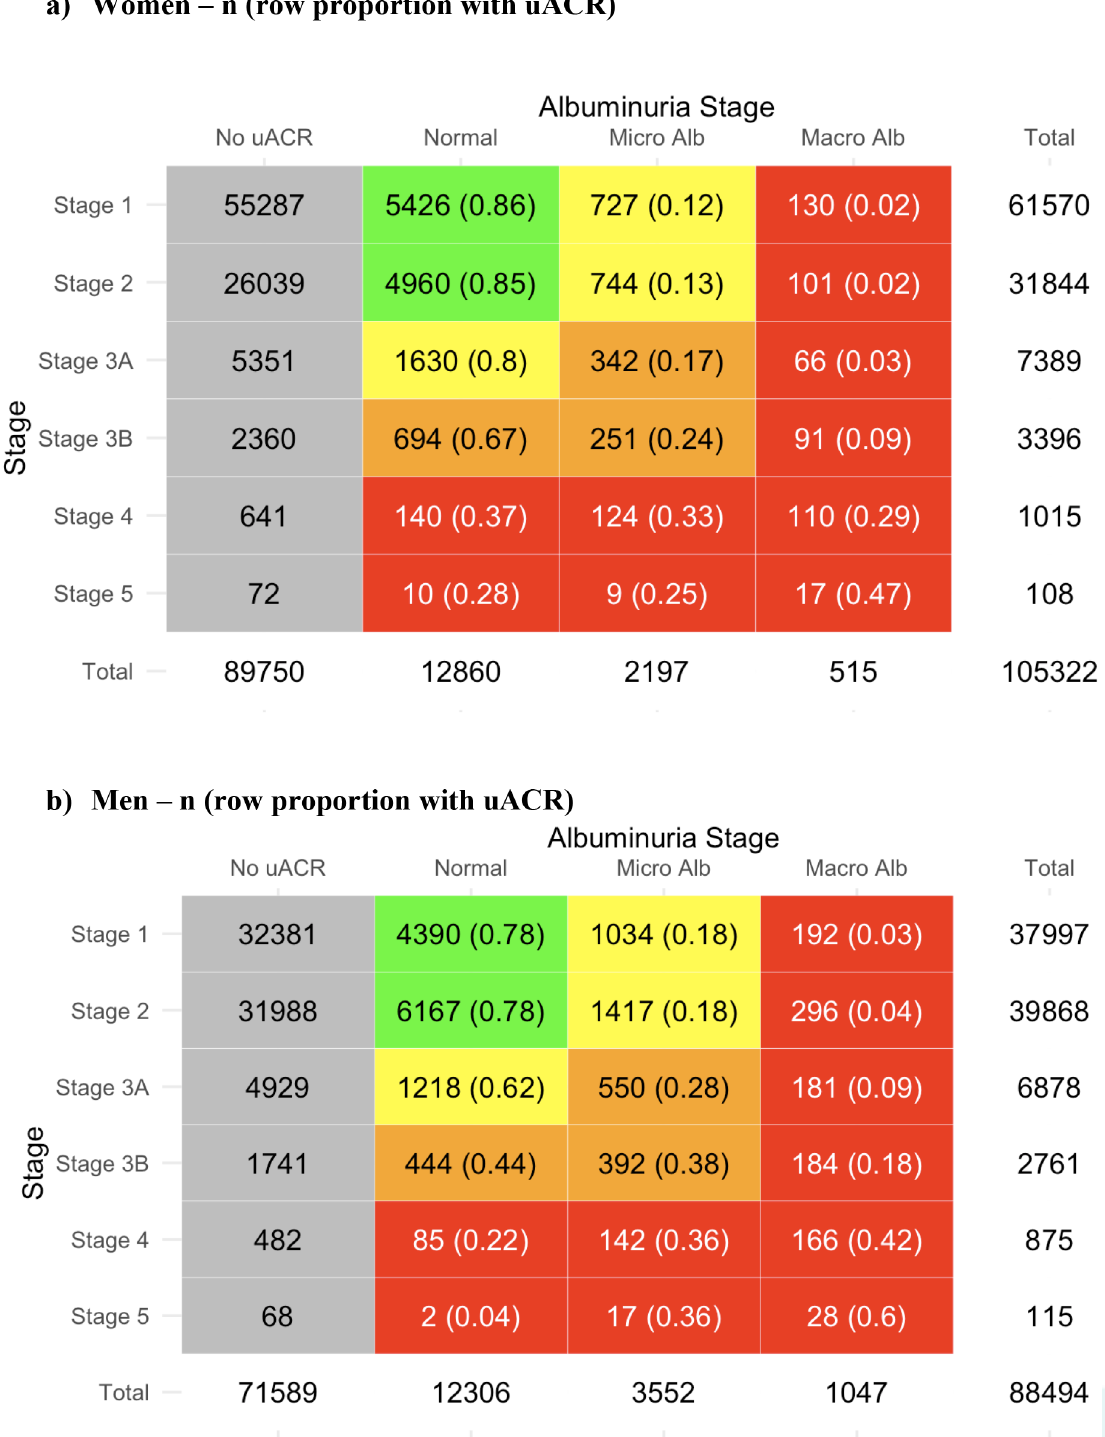
have a decline in function in that last 12 months prior to